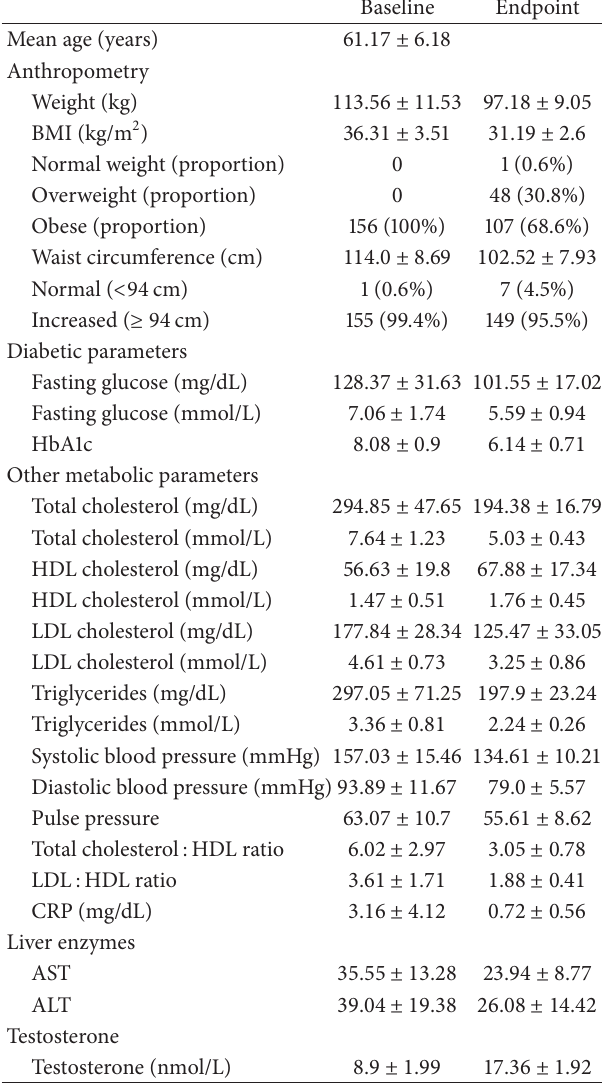
Table 1: Baseline characteristics and measures at the end of the observation period for 156 obese hypogonadal men with type 2 diabetes mellitus treated with testosterone undecanoate for up to 6